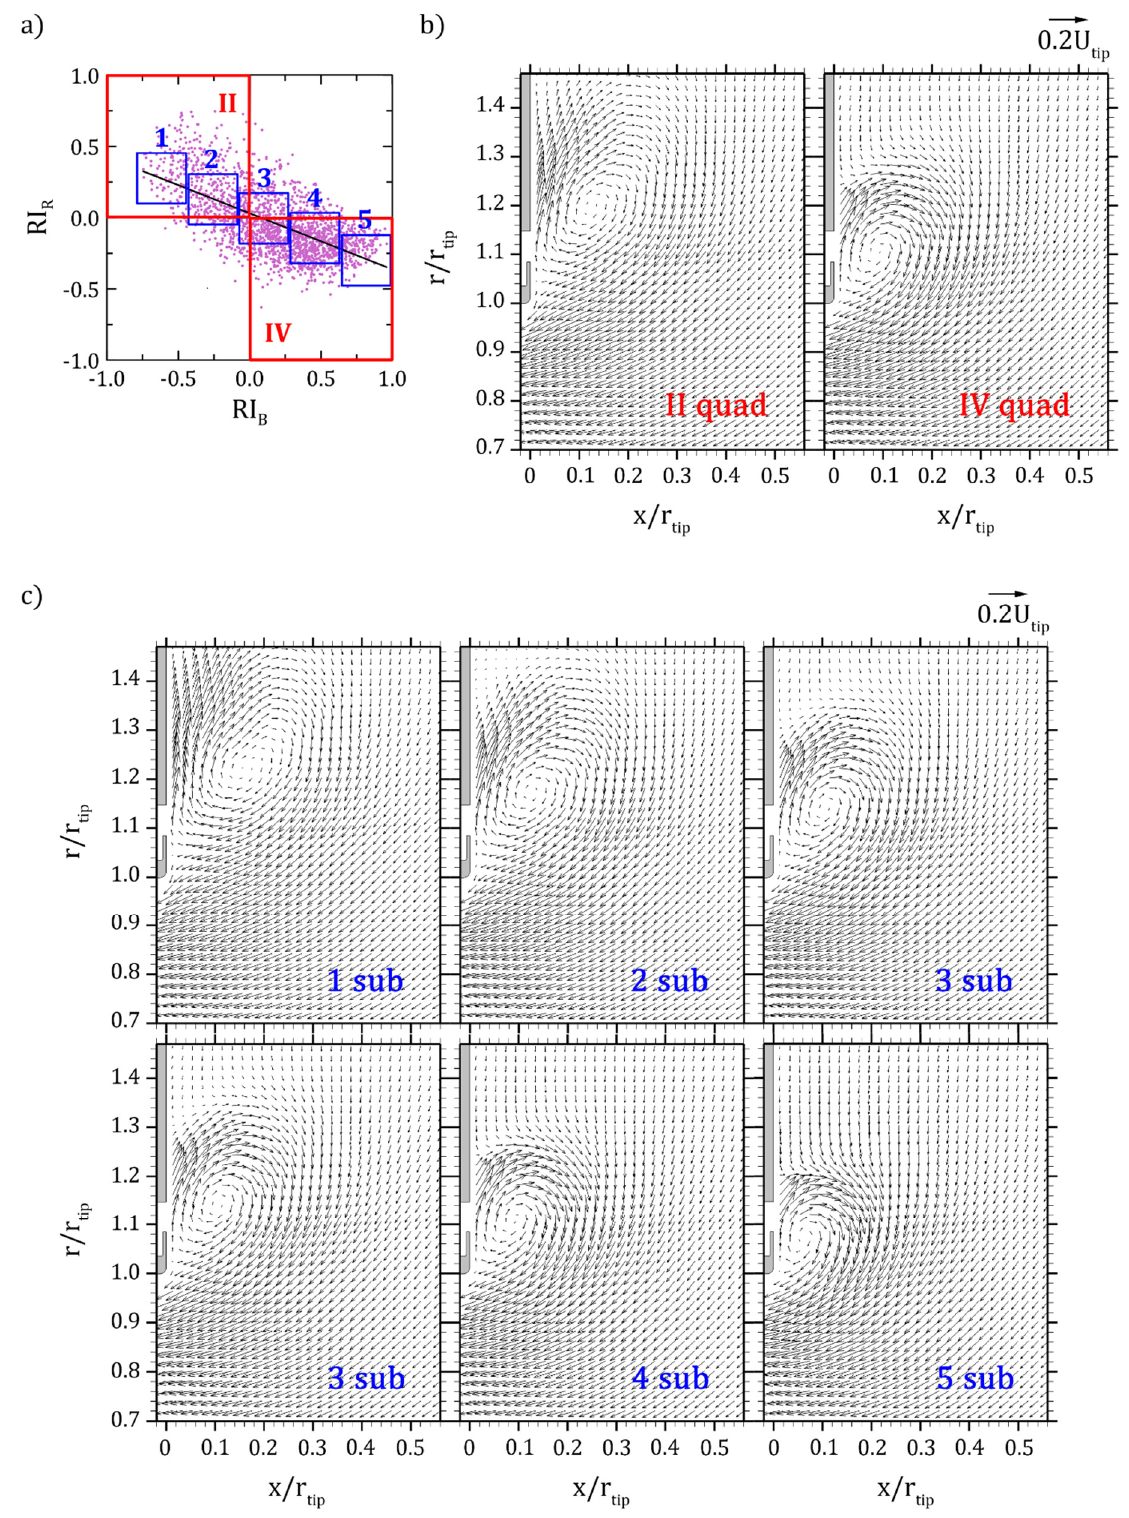
Figure 7. Averaged velocity fields at ψ = 0.0889: ( a ) subsets employed for the averaged velocity fields; ( b ) averaged fields related to the II and IV quadrants; ( c ) averaged fields related to smaller subsets (the case 3 sub was reported in both rows in order to ease